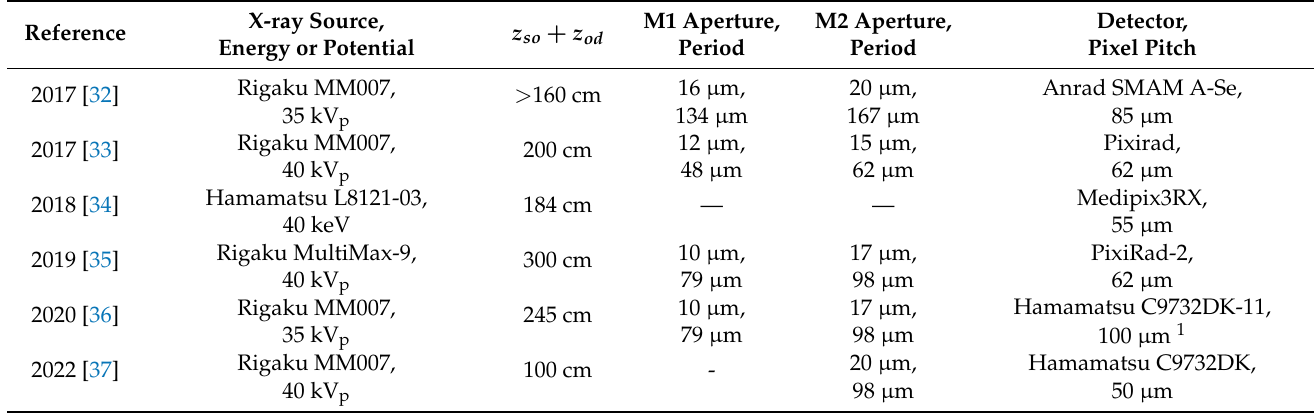
Table 1. List of today’s EI-XPCi systems with source, setup size (source to detector), masks, and de- tector